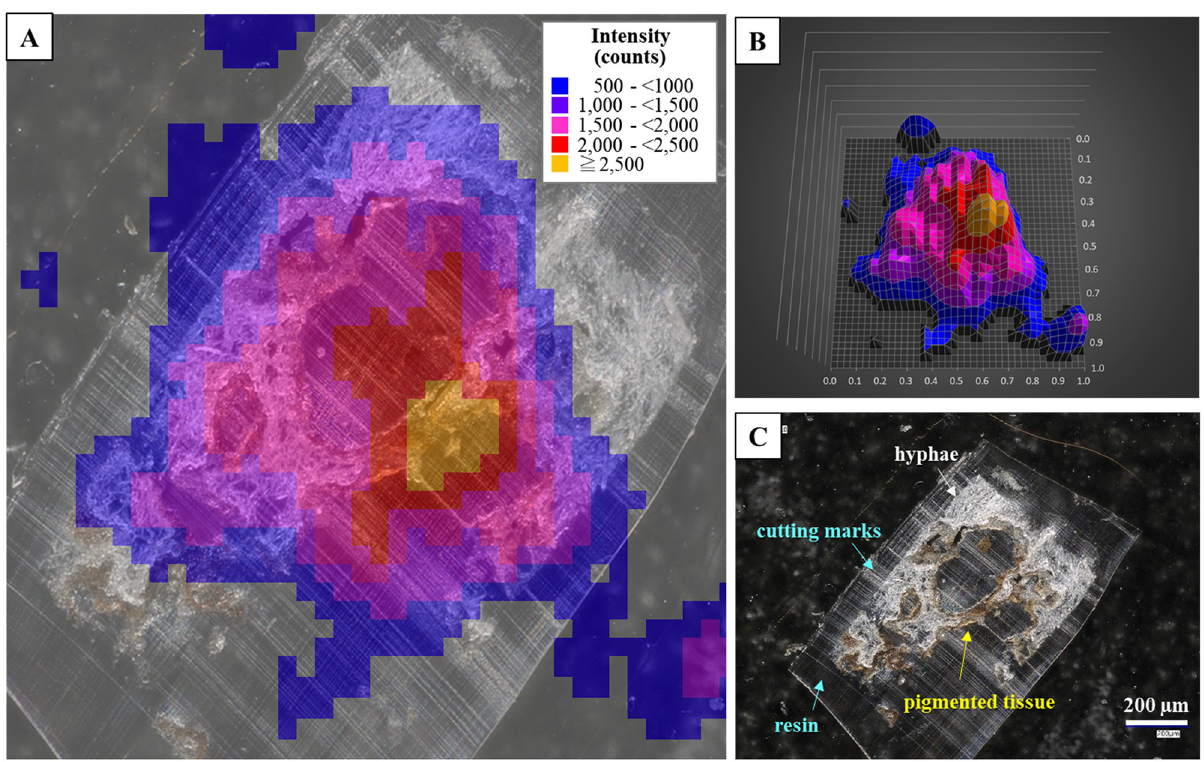
Fig 4. Radiocaesium distributions in tissue section of the FY2012PT sample with “c-4” as an example. (A) Overlapping image of the autoradiography result and tissue section image. The background counts were deducted from all count values. Each colour indicates the range of the PSL signal intensities, as shown in the legend, which also applies to (B). (B) Three-dimensional image of (A) in a 1 mm square area. (C) Image of tissue section taken with the digital microscope. The brown parts are pigmented tissue (yellow arrow), white parts are hyphae (white arrow), and transparent parts are resin (aqua arrow). Cutting marks from the glass knife appeared as a white linear pattern on the resin.